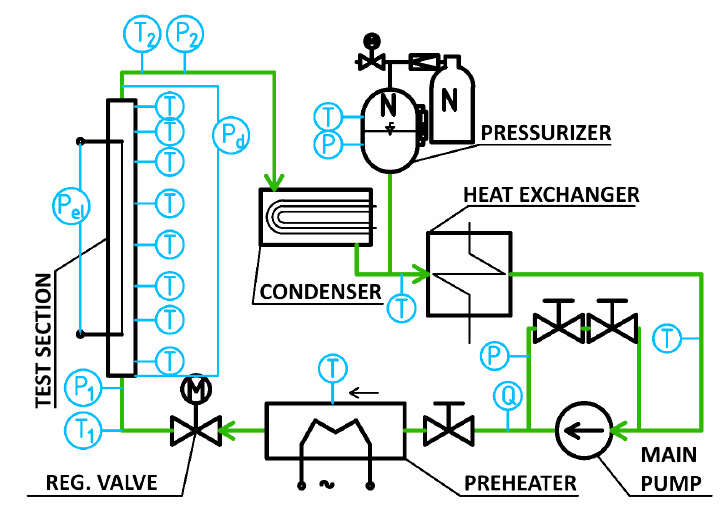
Figure 1. Process flow diagram of MRCHA test